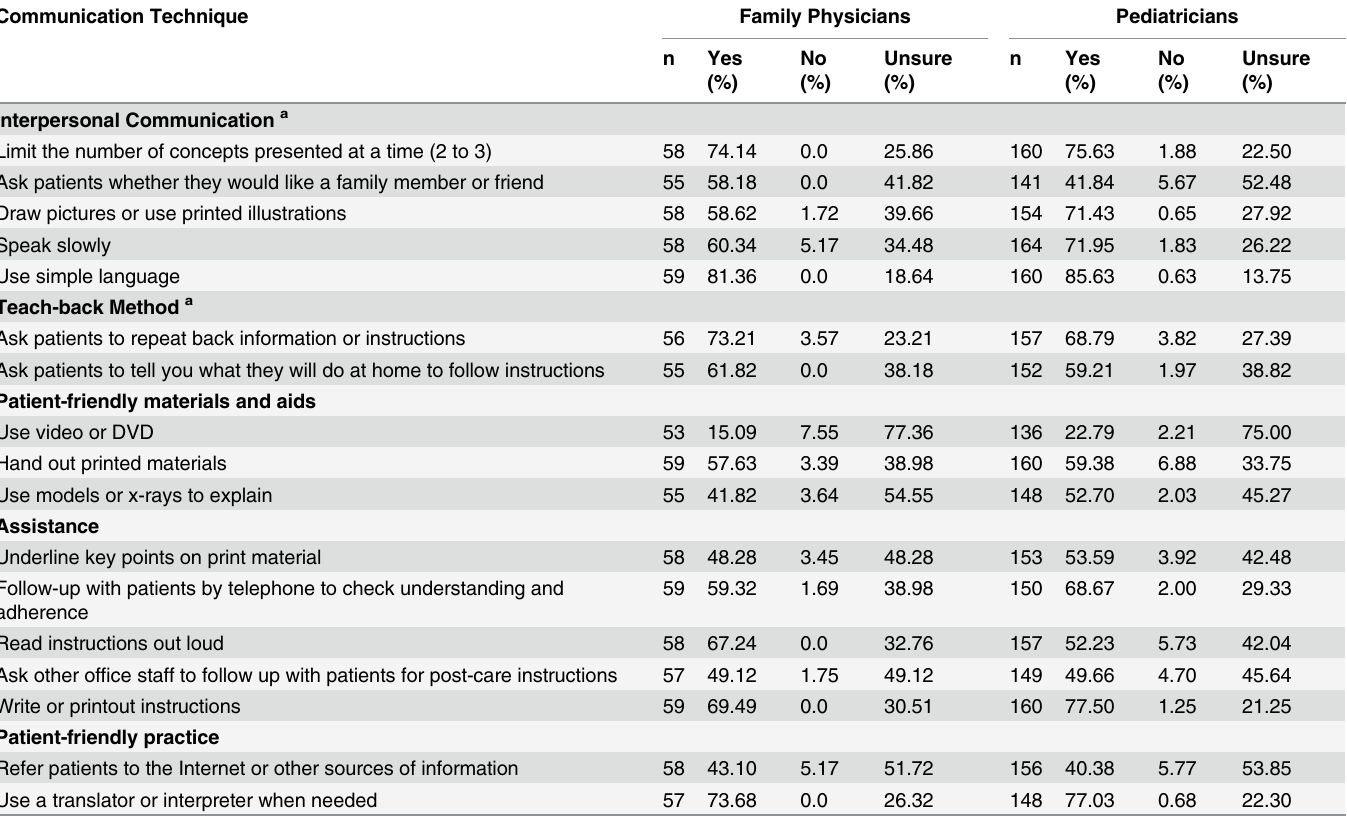
Table 4. Percentage distribution of the perceived effectiveness of techniques used routinely.